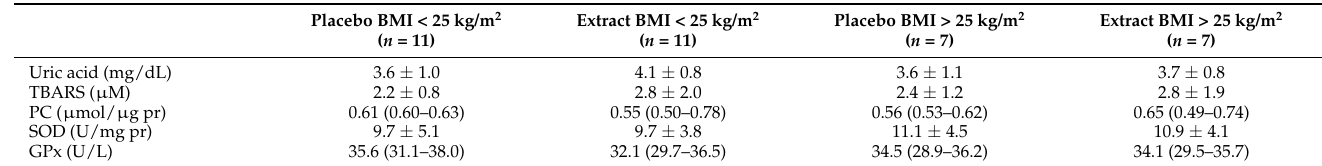
Table 2. Oxidative and endogenous antioxidant biomarkers of the different BMI categories in the two intervention groups at